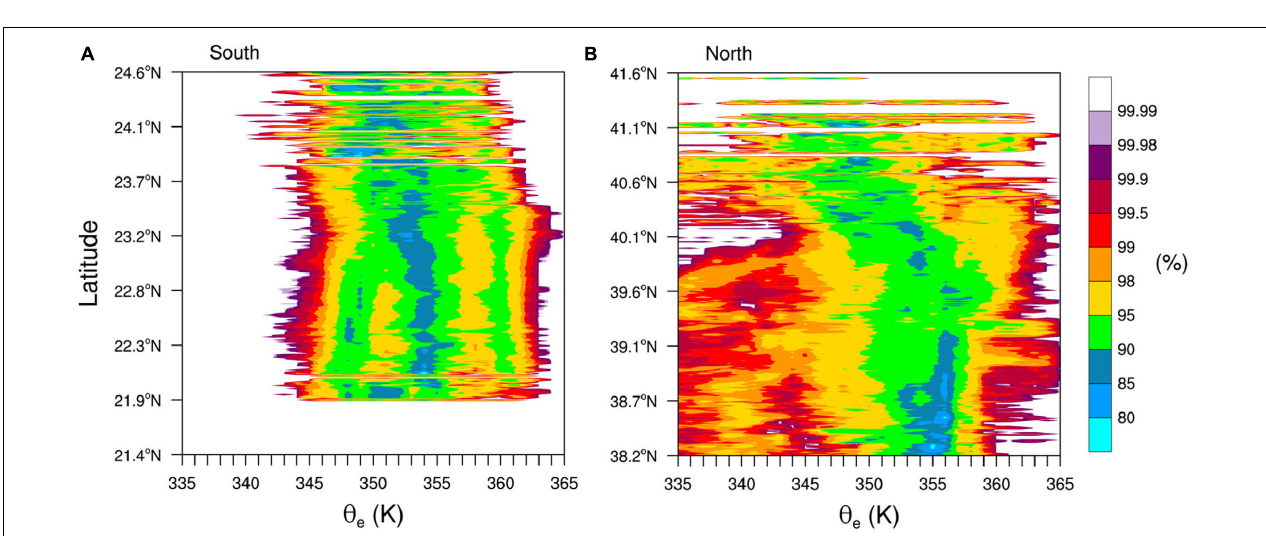
FIGURE 8 | (A-D) Daily maximum of region-averaged urban heat island effect ( (cid:49) θ , K, yellow histogram), urban dry island effect (moisture depict in K, L / C p (cid:49) q v , blue histogram), and urban heat stress change ( (cid:49) θ e , K, grown curve) under R 1– R 6 ( R = 30–80 km) city size scenarios in BJ, TJ, GZ, and SZ city regions. The fractional changes ( (cid:49) θ , L / C p (cid:49) q v , (cid:49) θ e ) are taken as difference between the R 1– R 6 experiment and Ideal run without city (refer to Group 2 experiment in Table 4 ).